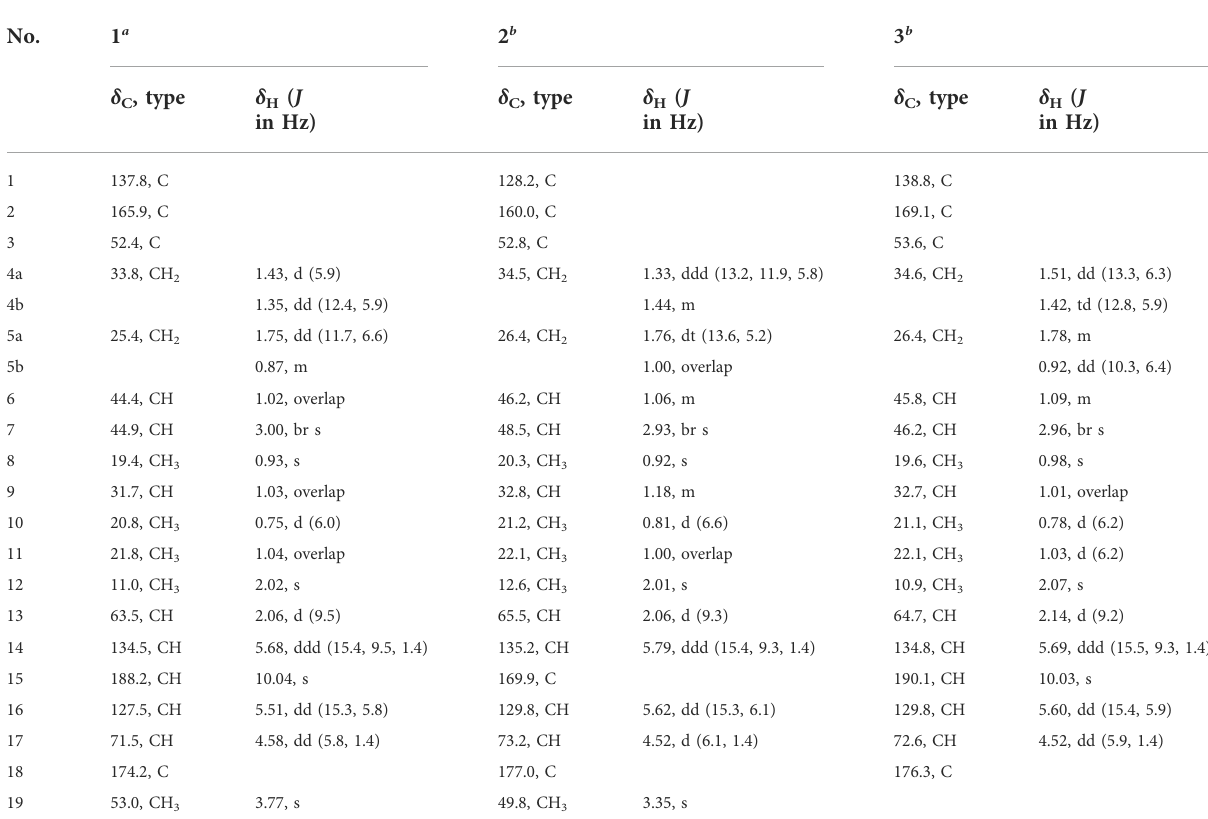
TABLE 1 1 H and 13 C NMR data for 1 –